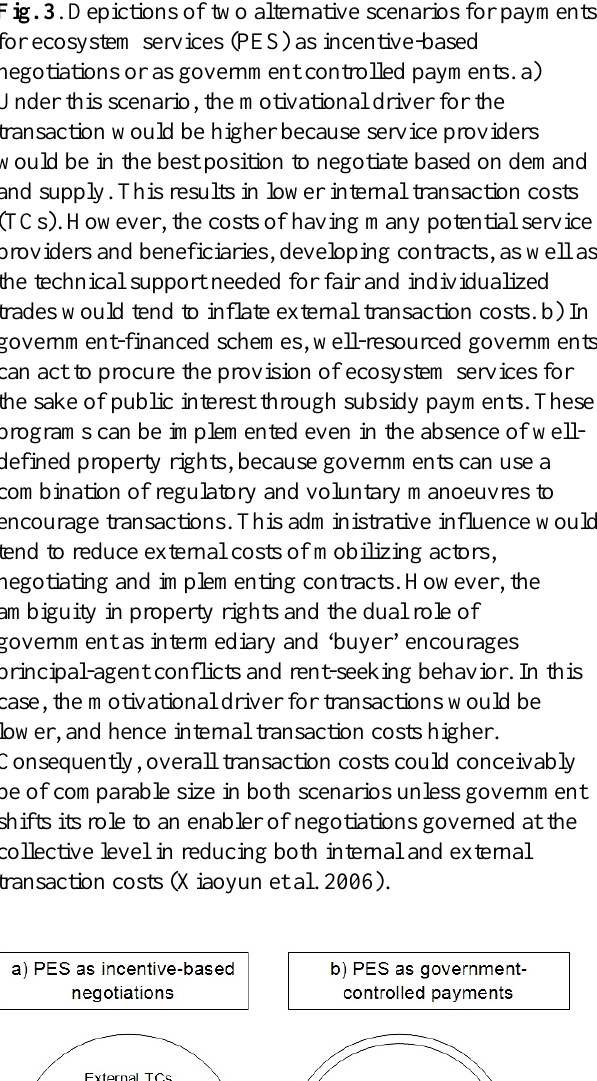
Fig. 3 . Depictions of two alternative scenarios for payments for ecosystem services (PES) as incentive-based negotiations or as government controlled payments.